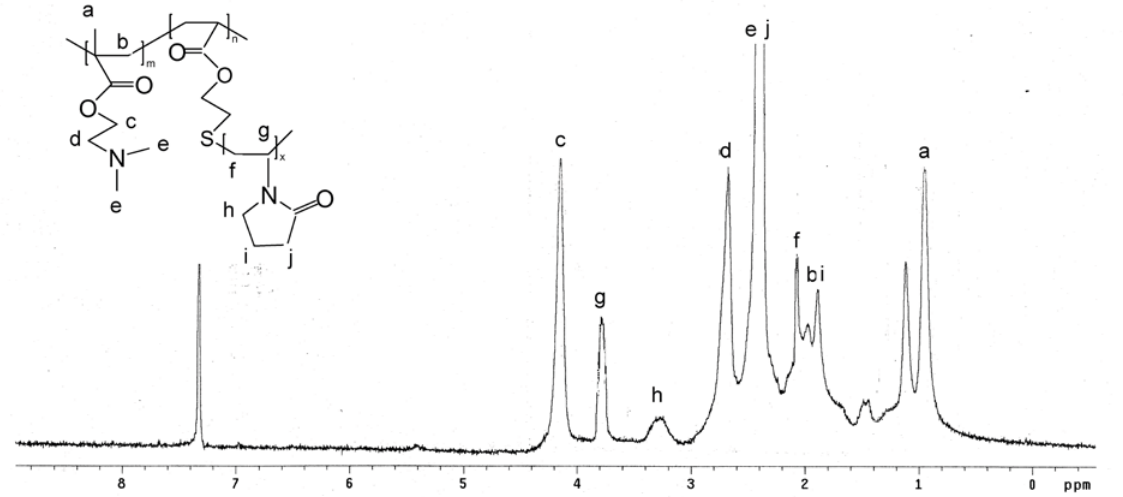
Figure 1. 1 H-NMR Spectra of P60 with signal assignments. Recorded at 300 MHz in CDCl